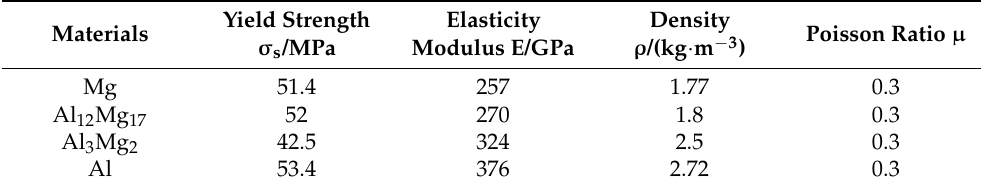
Table 4. General parameters of composite materials.